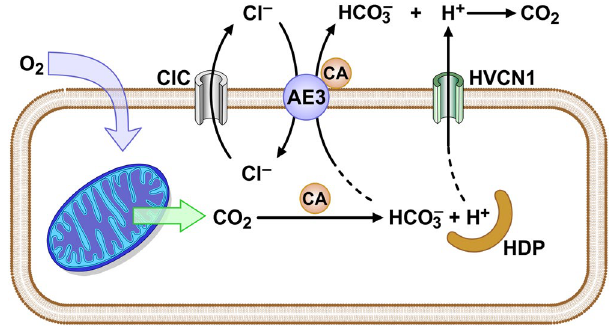
Figure 7. Model for the role of the AE3 Cl − /HCO 3 − exchanger in transport-mediated CO 2 disposal. Oxygen entering the myocyte is rapidly converted to CO 2 in mitochondria. CO 2 venting from mitochondria 13 is facilitated by CA-mediated conversion of CO 2 to HCO 3 − and H + , with H + buffered by histidyl dipeptides (HDP) and other components, thereby effectively blocking the back reaction by keeping the concentration of free H + low. CO 2 disposal is proposed to be mediated by a combination of HCO 3 − extrusion by AE3, Cl − recycling via Cl − channel activity, H + -extrusion via HVCN1 during each depolarization, and extracellular carbonic anhydrase (CA) activity to generate CO 2